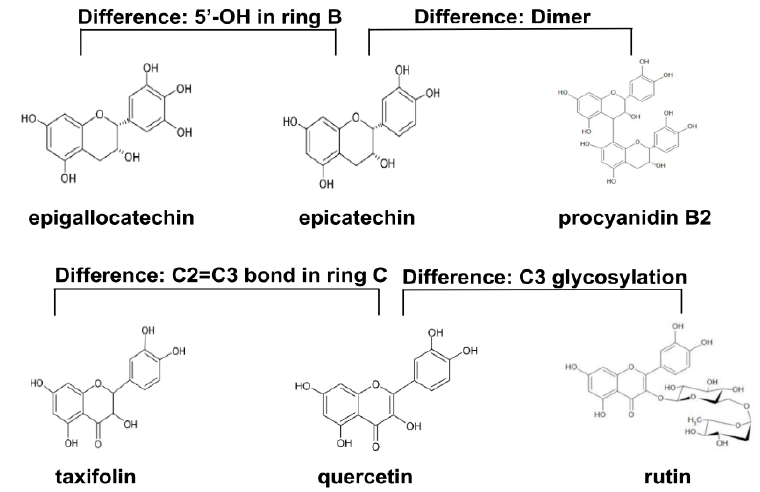
Figure 1. The chemical structures of procyanidin B2, epicatechin, epigallocatechin, taxifolin, quercetin, and rutin.